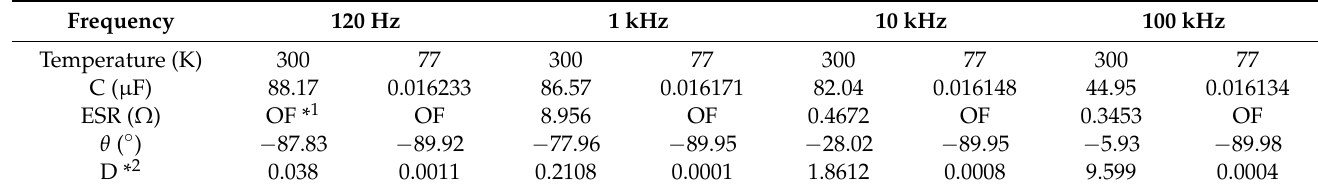
Table 3. The electrolytic capacitor test results at different temperatures and frequencies.